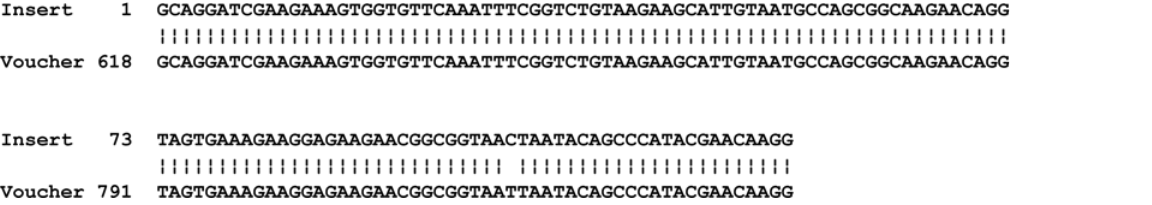
Fig 4. Sequence alignment. Cloned insert with yellow perch mitochondrial cytochrome oxidase subunit 1 (GenBank voucher PEFL-ON-BLAC-4 –